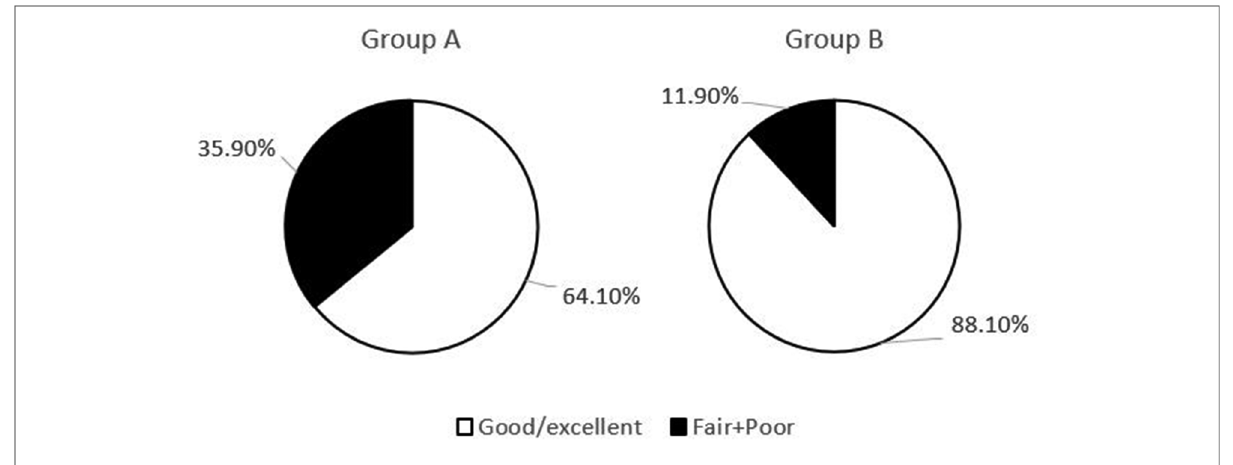
FIGURE 3 Comparison of good/excellent rates of AOFAS score between the two groups.